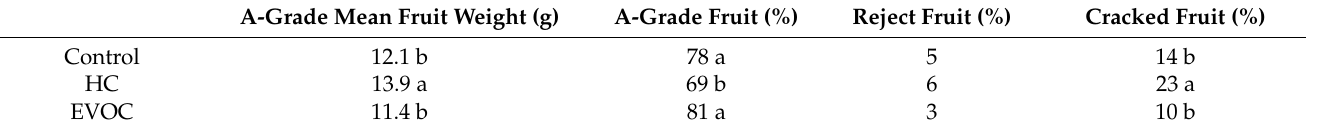
Table 5. Effect of dormancy-breaking agents on the fruit pack-out of the sweet cherry cultivar ‘Lapins’ at commercial harvest. HC = hydrogen cyanamide; EVOC = emulsified vegetable oil compound.